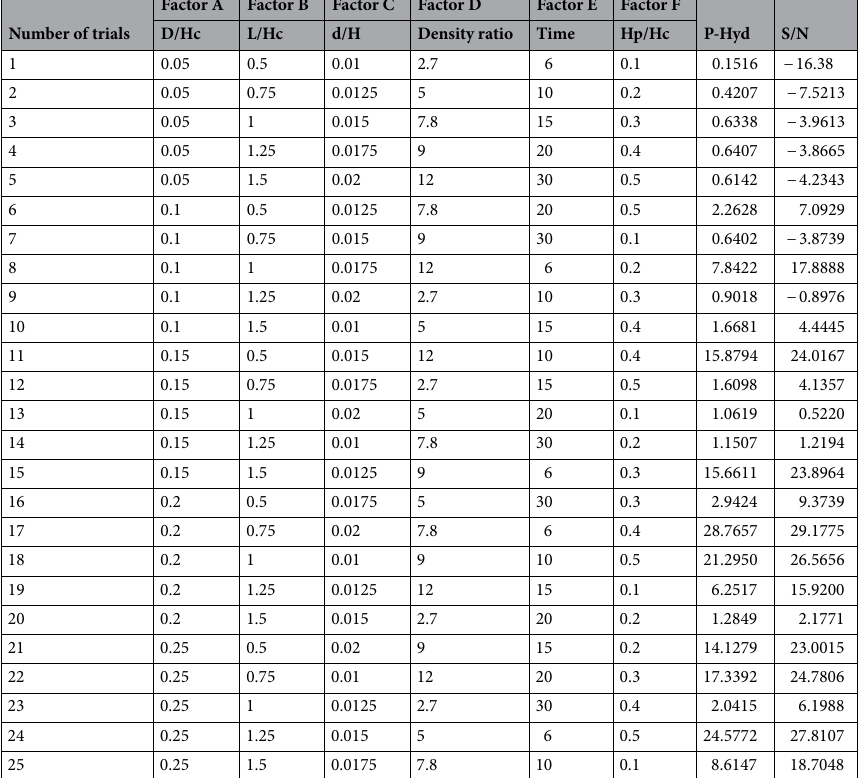
Table 10. Taguchi design of L25 orthogonal array.